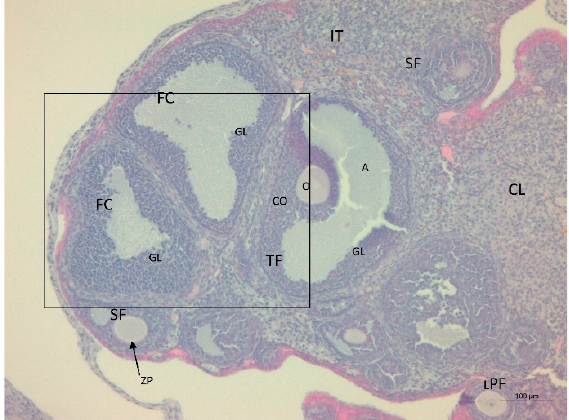
Figure 8. Histological sections of ovaries with follicular cysts (FC) in LET-treated mice on the HF/HFr diet. TF: tertiary follicle; O: oocyte; GL: irregular granulosa layer; CO: cumulus oophorus; A: antrium; LPF: late